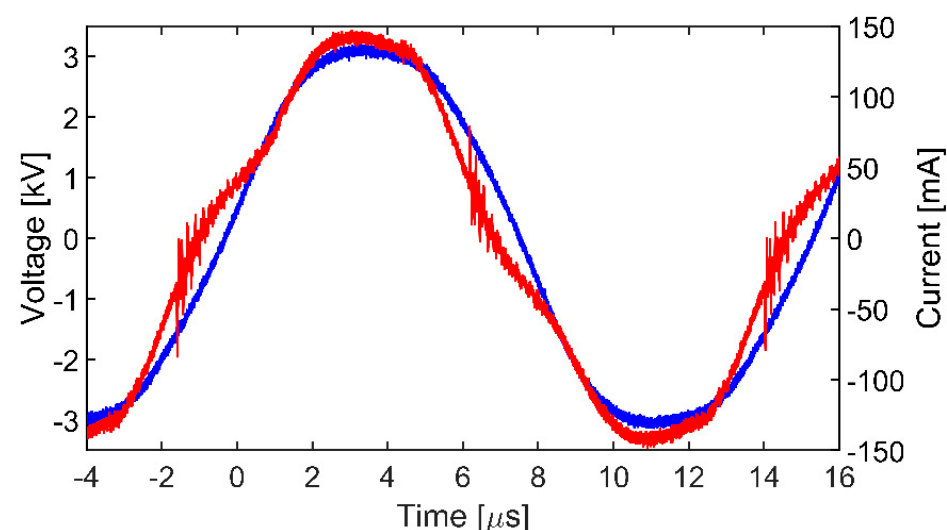
Figure 7. Current and voltage waveforms of the HCPJ generated at 65 kHz and 400 W of input power of the HV generator. The voltage waveform is given in blue while the current waveform is given in red.